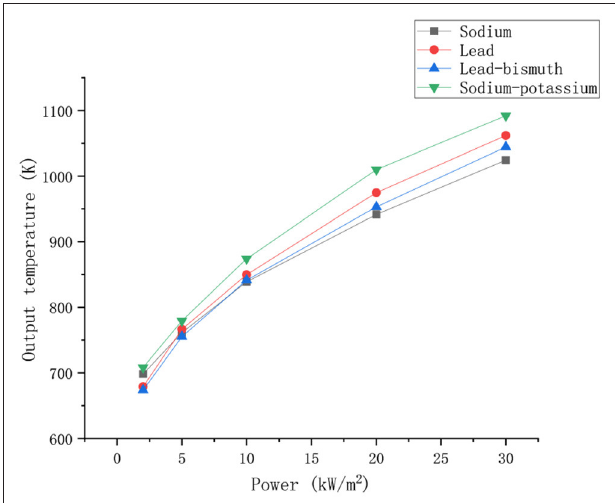
FIGURE 7 | Effect of heating power on outlet temperatures of different liquid